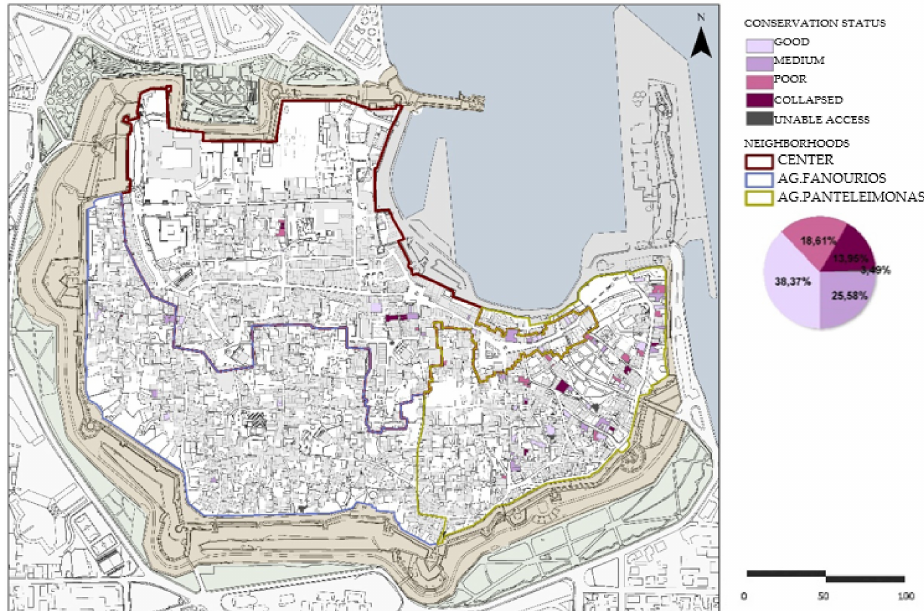
Figure 9. Existing maintenance status